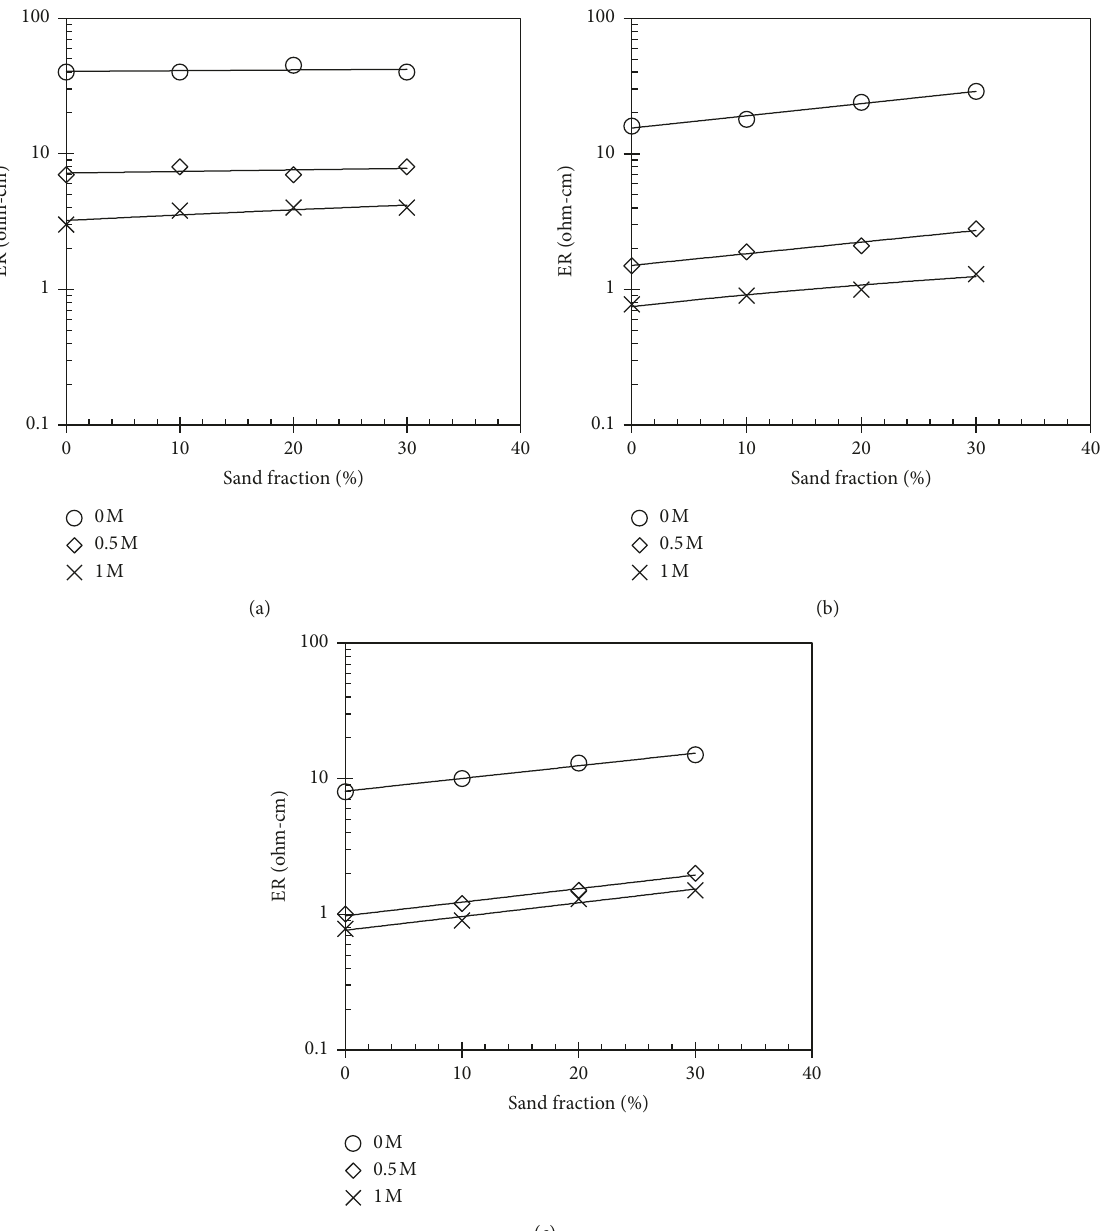
Figure 9: ER against sand fraction in NaCl solutions (0M, 0.5M, and 1M) at (a) W